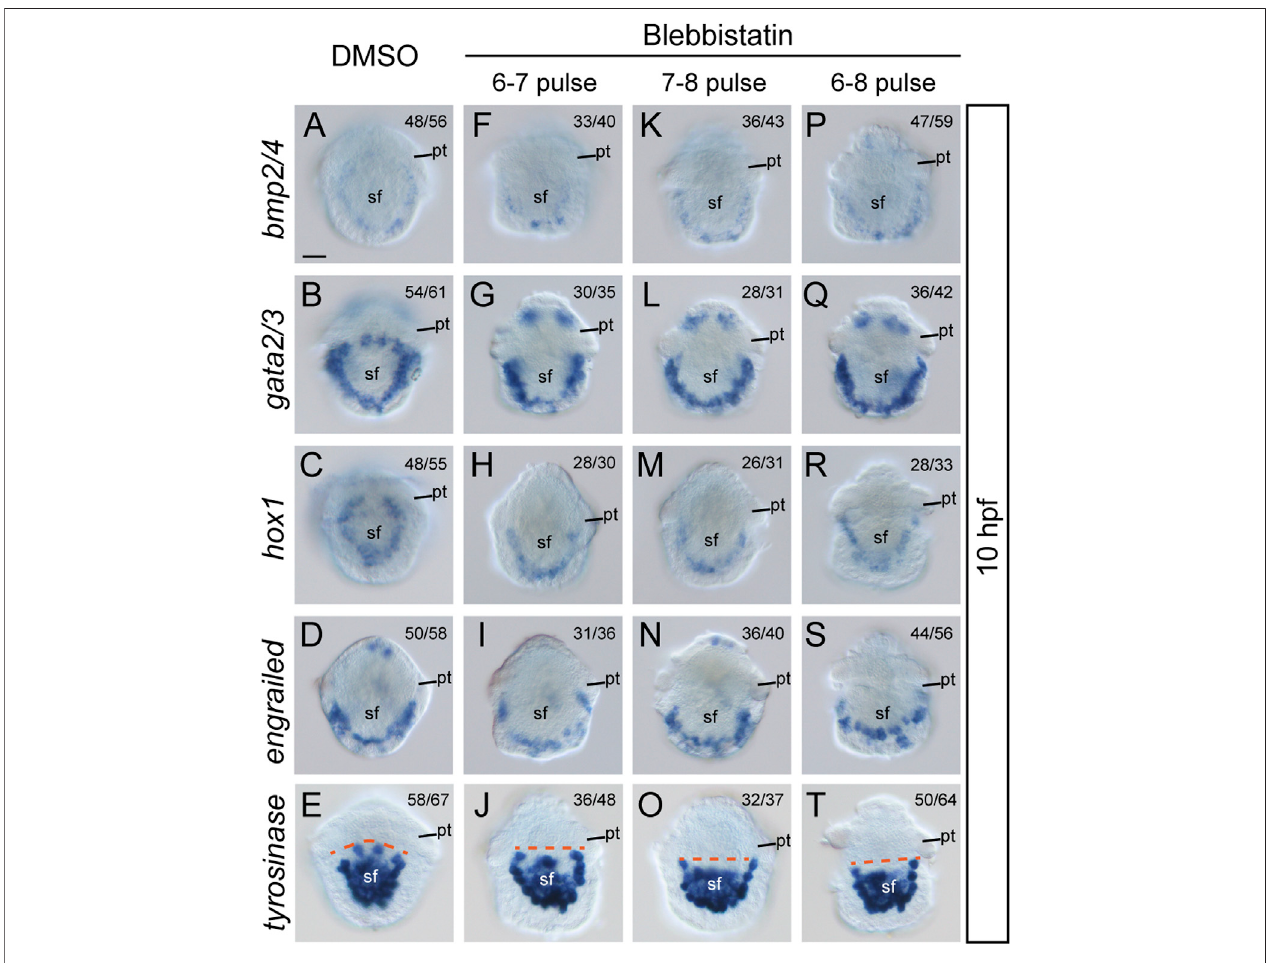
FIGURE 7 | Expression of fi ve pSF genes at 10 hpf after blebbistatin treatments. All panels show dorsal views, anterior to the top. Dashed lines in E , J , O , and T indicate the anterior edge of the tyrosinase expression regions. pt, prototroch. sf, shell fi eld. The bar represents 25 μ m.